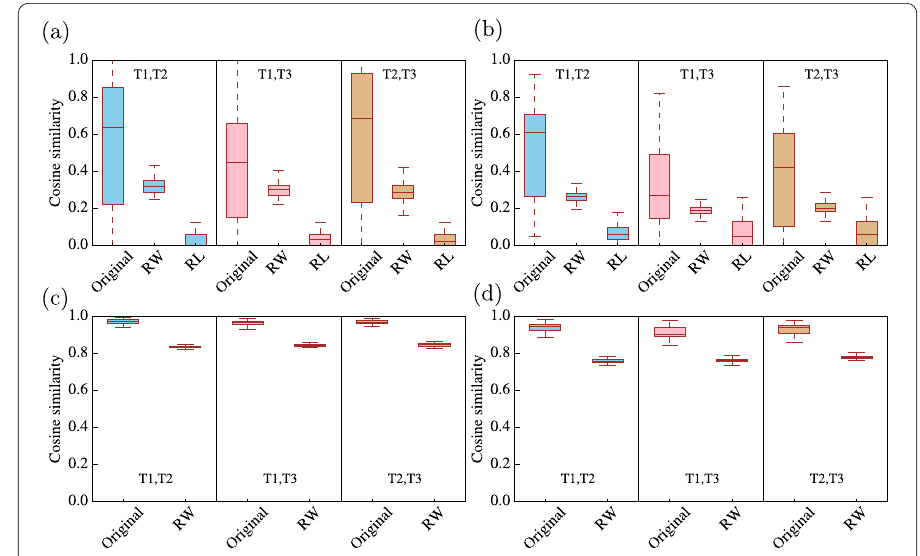
Figure 4 Boxplots of the cosine similarity distributions within the networks aggregated in different terms (T1, T2, T3), compared with the same distributions for networks with reshuffled weights (RW) or links (RL). ( a ) Communication networks—weights given by aggregated call durations. ( b ) Co-presence networks—weights given by aggregated durations. ( c ) Questionnaire—Q1. ( d ) Questionnaire—Q2. For the questionnaire cases the RL and RW procedures are equivalent as the networks are fully